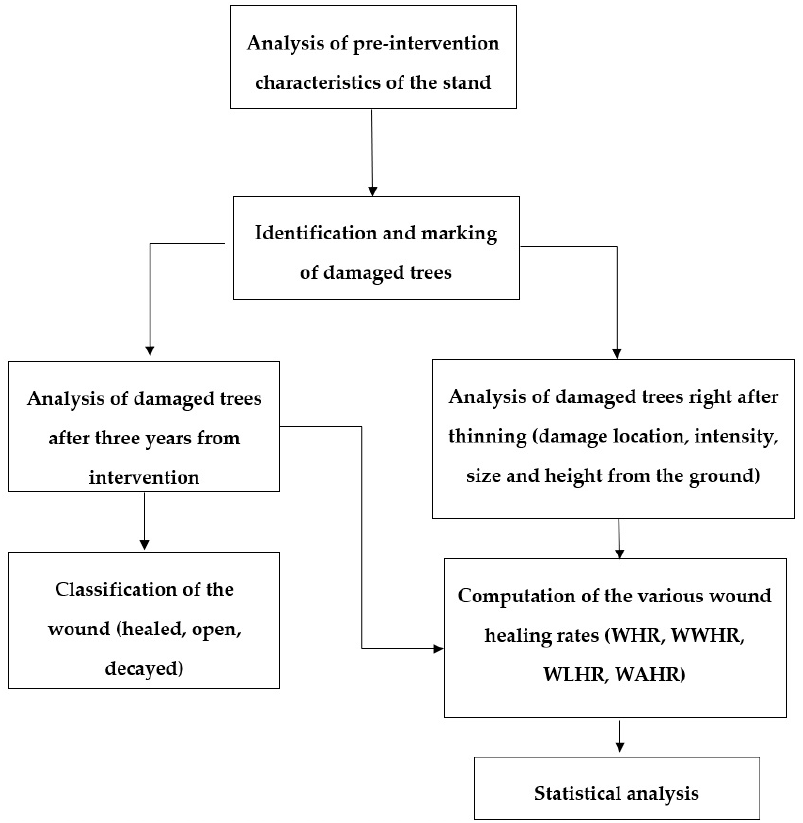
Figure 1. Schematic representation of the experimental design. WHR: wound healing rate; WWHR: wound width healing rate; WLHR: wound length healing rate; WAHR: wound area healing rate.